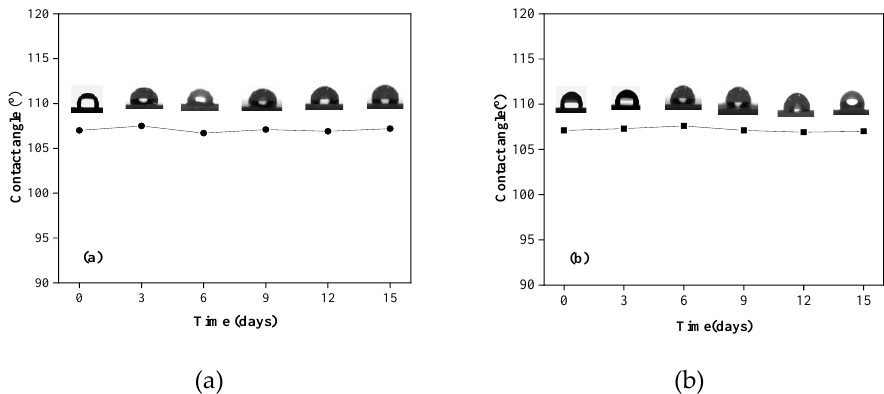
Figure 7. Contact angle changes after immersed in simulated leachate ( a ) pH = 2.0, ( b ) pH = 12.0.